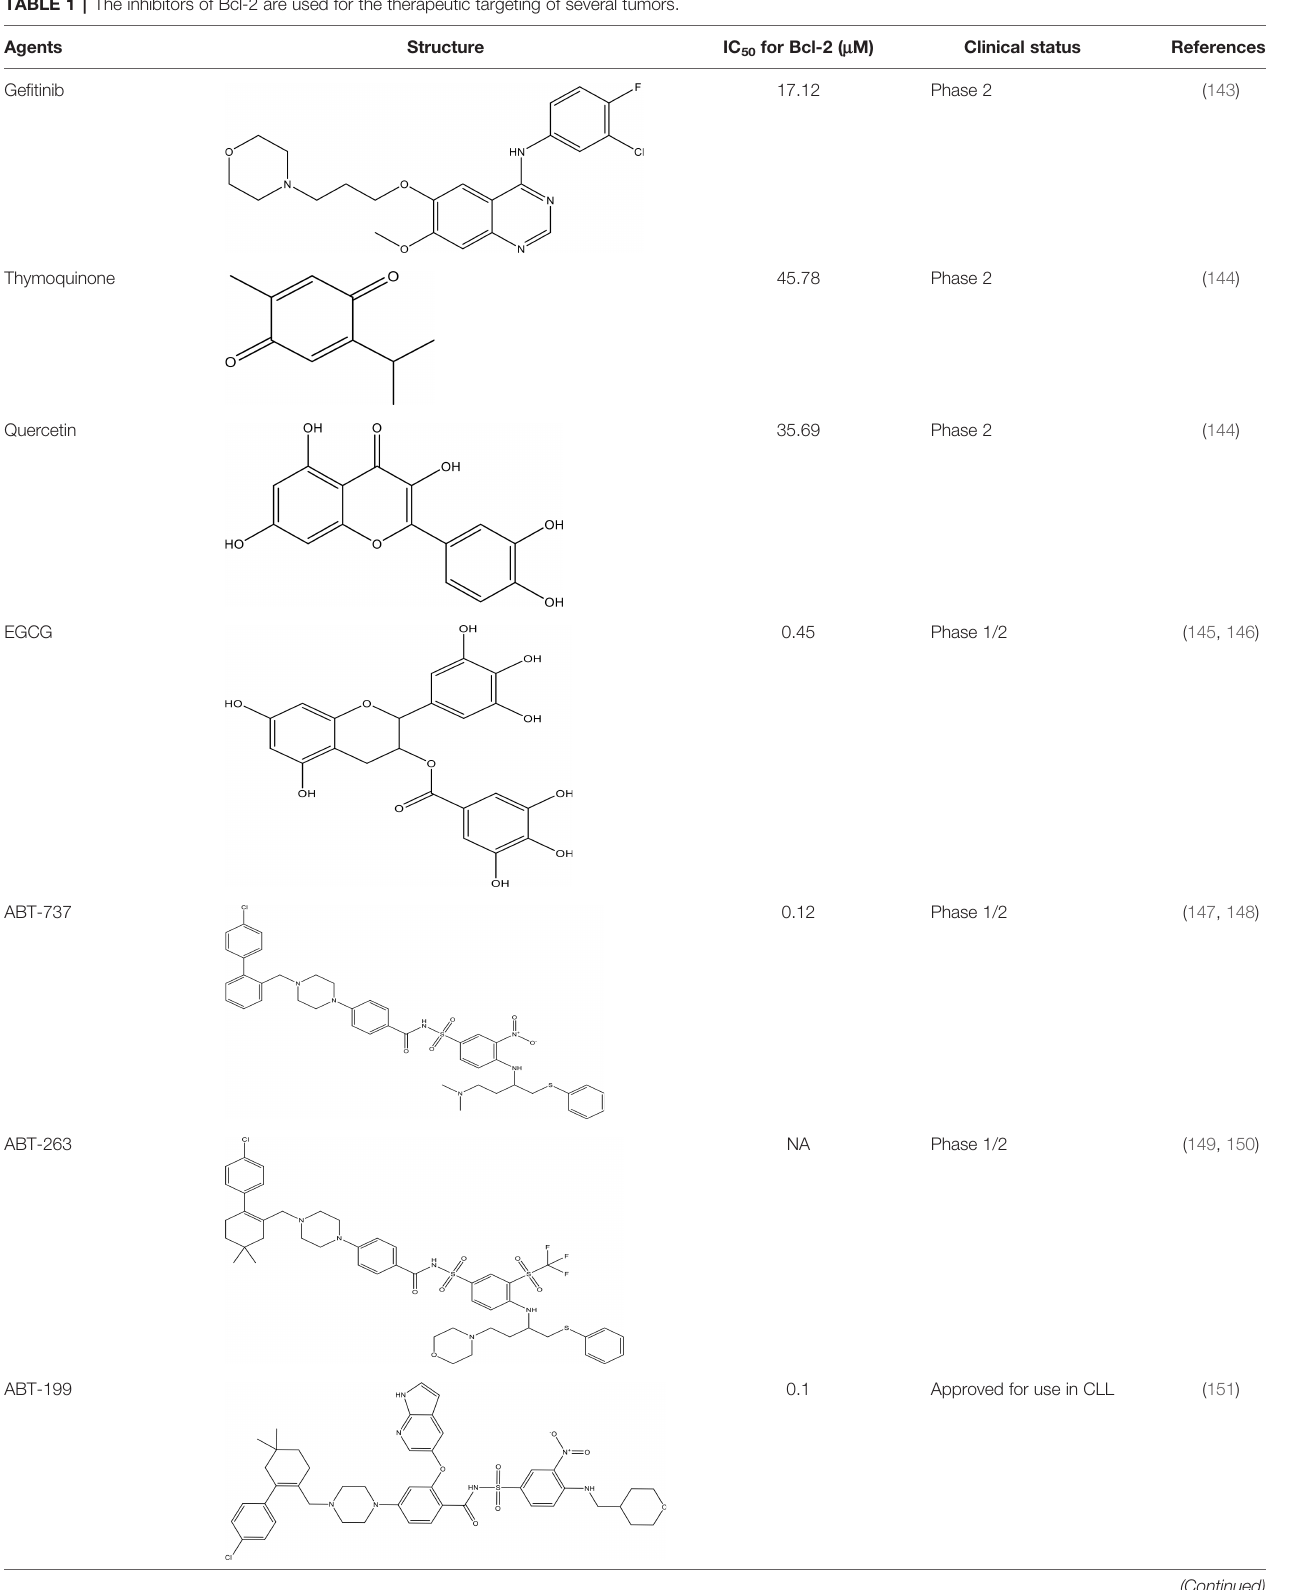
TABLE 1 | The inhibitors of Bcl-2 are used for the therapeutic targeting of several